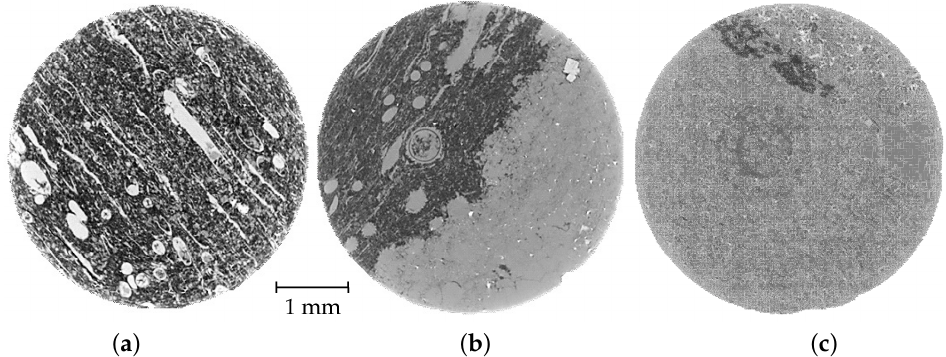
Figure 9. Representative micro-CT slices of mini-cores taken from the whole core #551: ( a ) detritus (tentaculites) in calcite matrix with organic matter—organic-rich wackestone; ( b ) contact of organic-rich wackestone (dark) and crystalline limestone (light); ( c ) crystalline